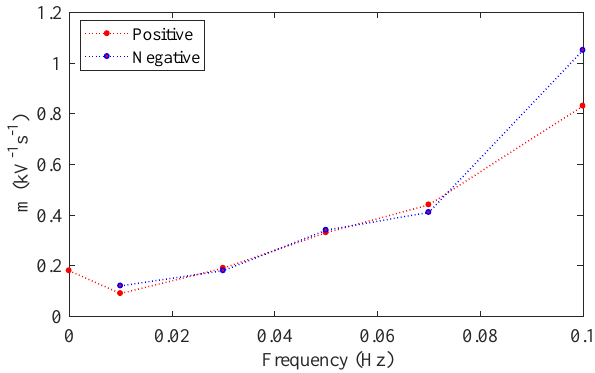
Figure 11. Frequency dependence of the voltage variation in R tot .